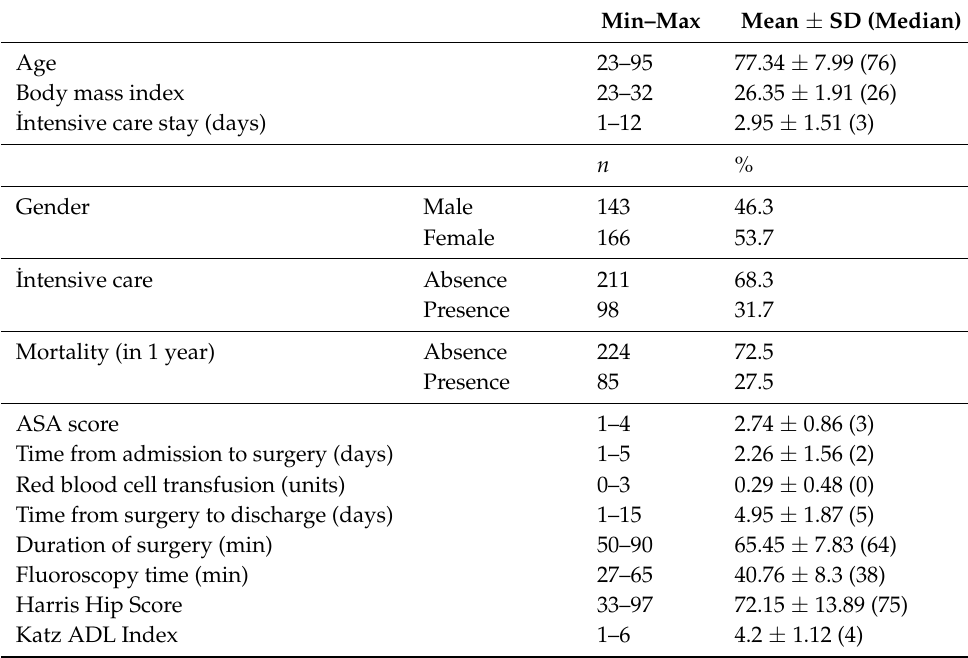
Table 2. The descriptive features of the patients.